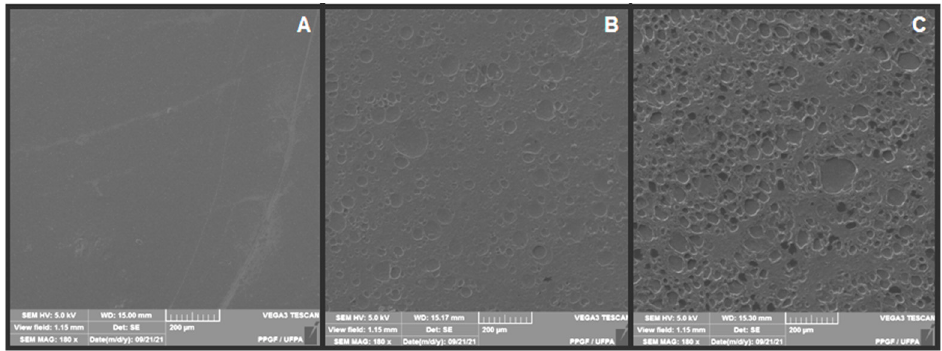
Figure 6. Micrographs obtained by SEM of membranes at the amplitude of 5 kv: ( a ) M0, ( b ) M4, ( c ) M5. The bar is 200 μ